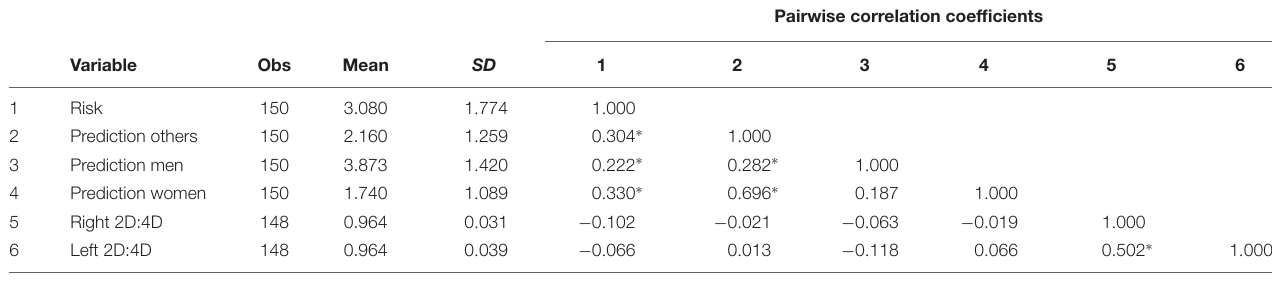
TABLE 2 | Descriptive statistics.